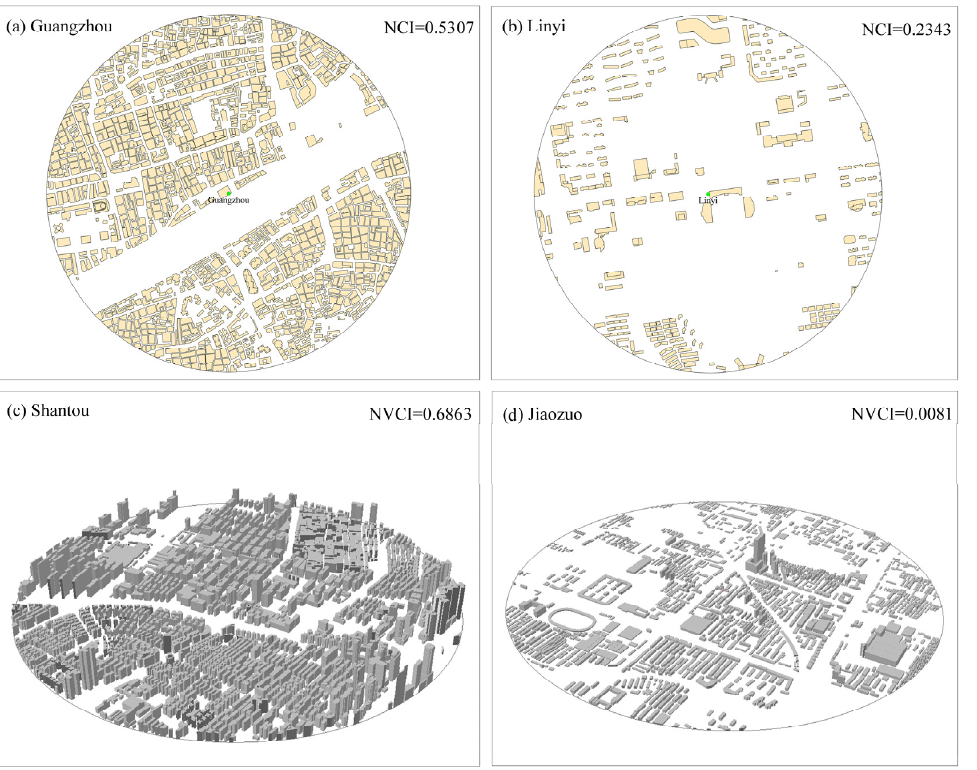
Figure 8. Urban form in a 1 km buffer with the maximum NCI ( a ), minimum NCI ( b ), maximum NVCI ( c ), and minimum NVCI ( d ). Urban form is more compact as NCI or NVCI approach 1.